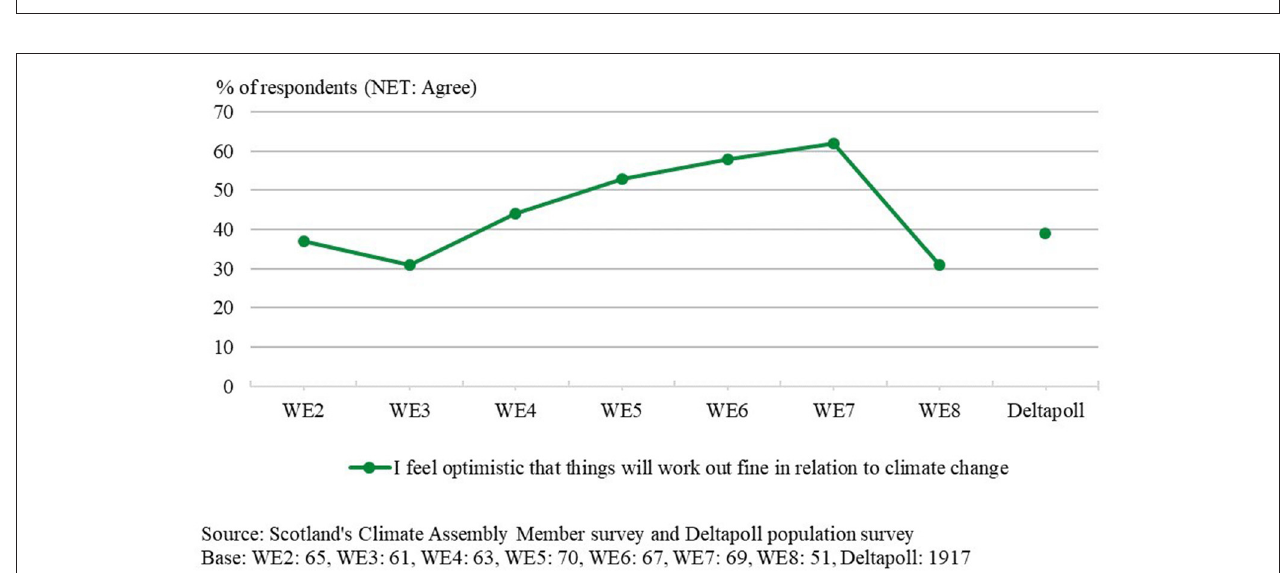
FIGURE 2 | Assembly members and public optimism about climate